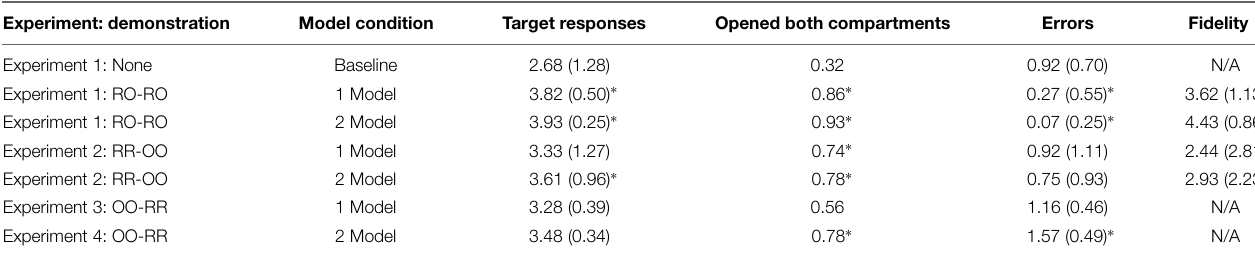
TABLE 2 | Mean (SD) for the various measures used to evaluate